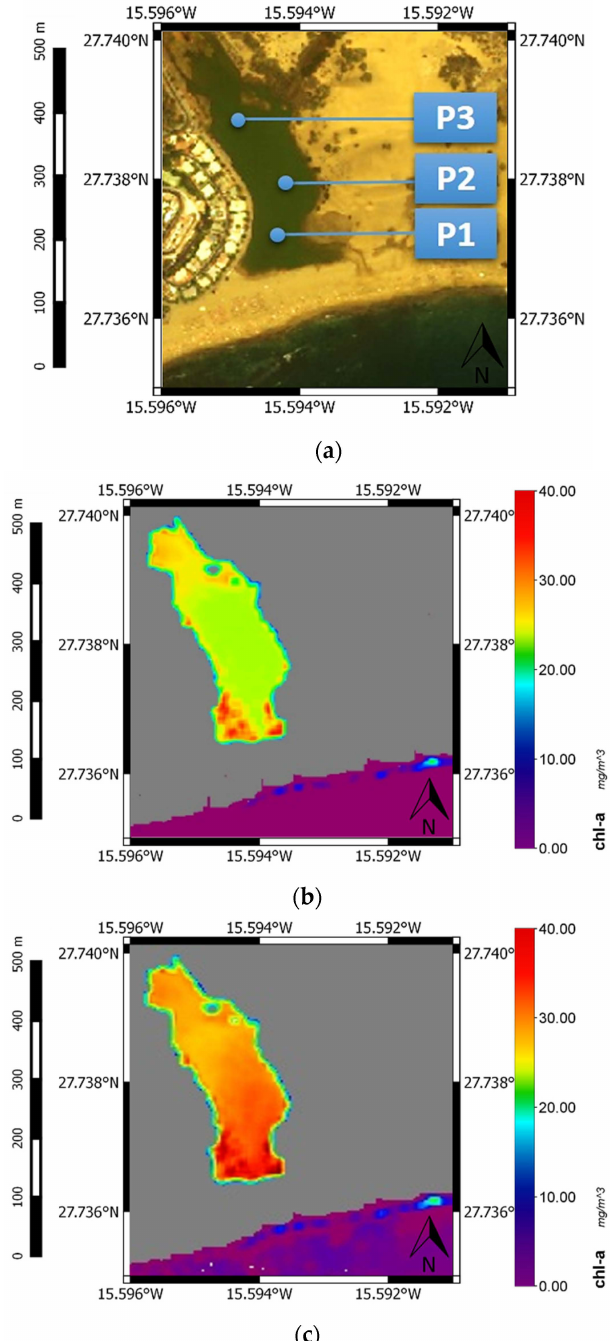
Figure 8. ( a ) In situ Chl-a samples in Maspalomas inner lake; ( b ) Chl-a concentration map by using classical + RTE deglinting algorithm; ( c ) Chl-a concentration map by using developed deglinting